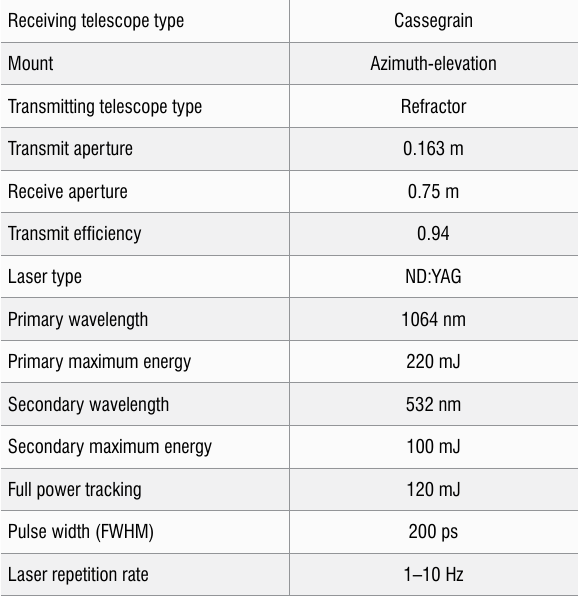
Some technical specifications of the MOBLAS-6 SLR station